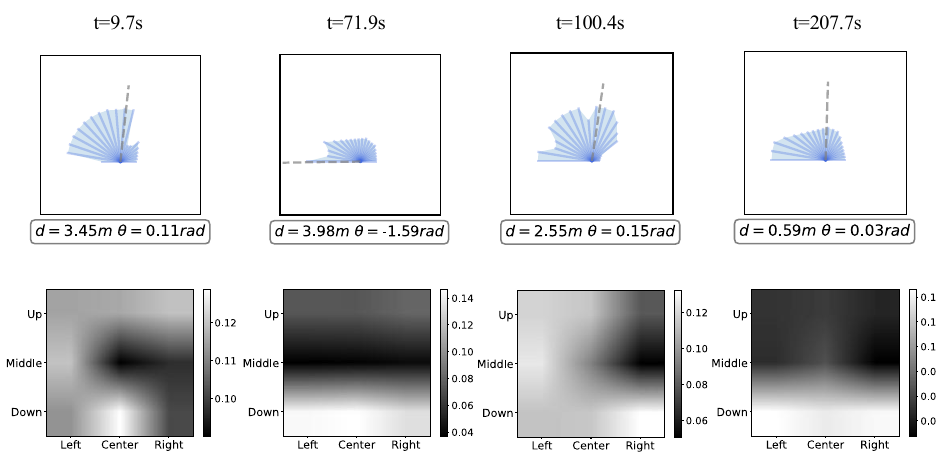
Figure 11. Observation